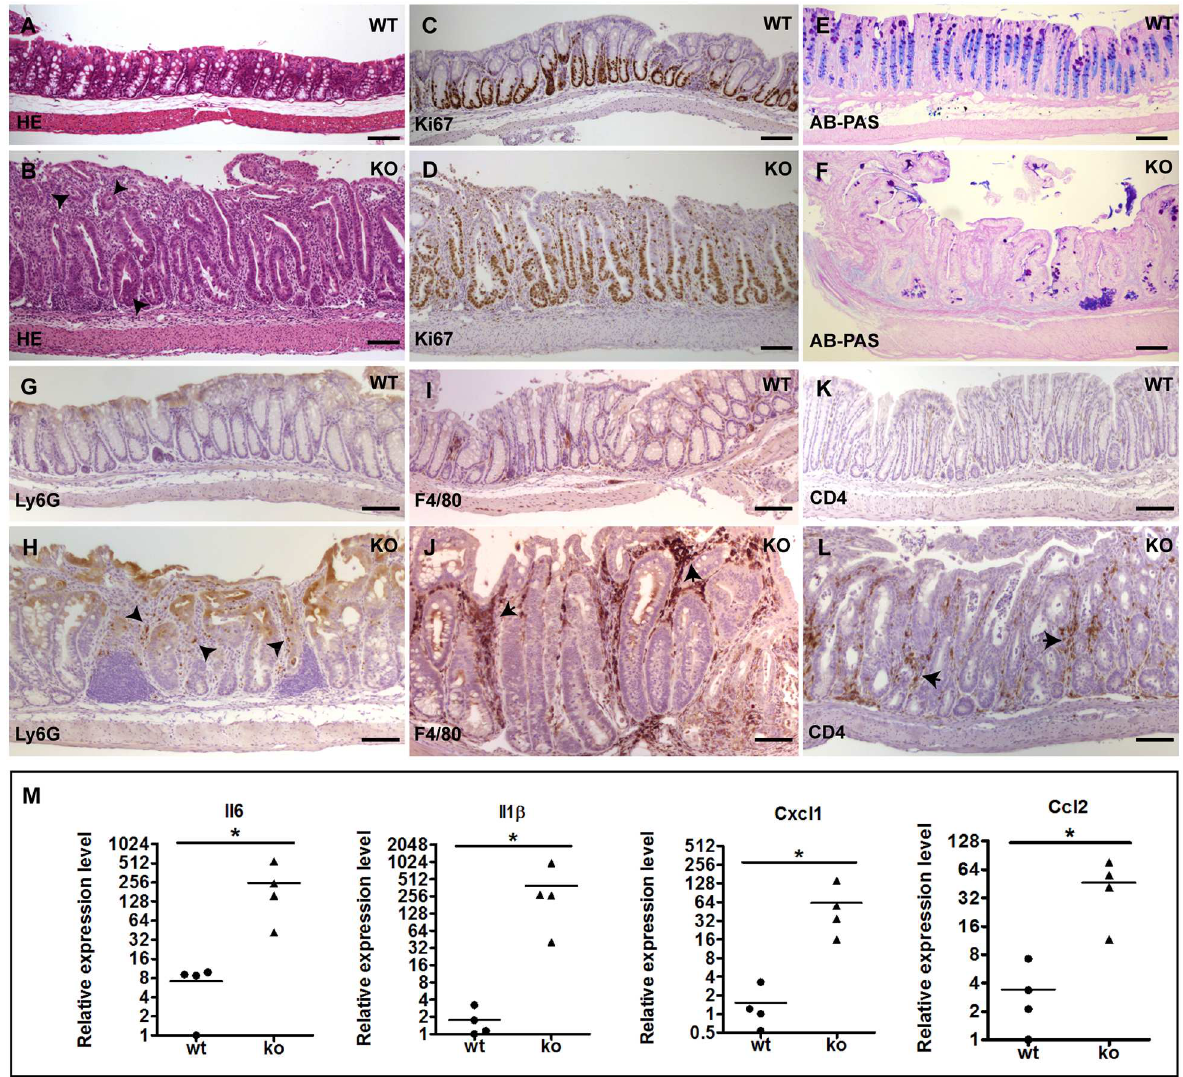
Fig 3. The IEC-specific hnRNPI knockout mice develop spontaneous colitis. (A) and (B) Hematoxylin and Eosin (HE)–stained sectionsshow severe inflammation in the colonic epithelium of the knockout mice (B). Arrowheads in B show crypt abscesses. (C) and (D) Immunohistochemical stainingwith an anti-Ki67antibody shows hyperproliferation of colonicepithelialcells in the knockout mice (D). (E) and (F) Alcian Blue-PASstaining shows loss of goblet cells in the colonicepitheliumof the knockout mice (F). (G) to (L) Immunohistochemicalstainingshows increasednumber of inflammatory cells in the lamina propriaof the knockoutcolon with indicated antibodies. (G) and (H) show neutrophils.Arrowheads in H point neutrophilsin the knockout mice. (I) and (J) show macrophages. Arrows in J point macrophages in the knockout mice. (K) and (L) show CD4 positive T-cells. Arrows in L point CD4 positive T-cells in the knockout mice. (M) Real-timePCR shows increasedexpressionof the pro-inflammatory cytokines and chemokinesin the colonic epithelial cells of the knockout mice. Each symbol in all graphsindicates geneexpressionlevel relative to Gapdh of individual mice. Bars show mean value. In both the wild-typeand knockout groups, n = 4 mice. * p < 0.05. Scale bars, 50 μ